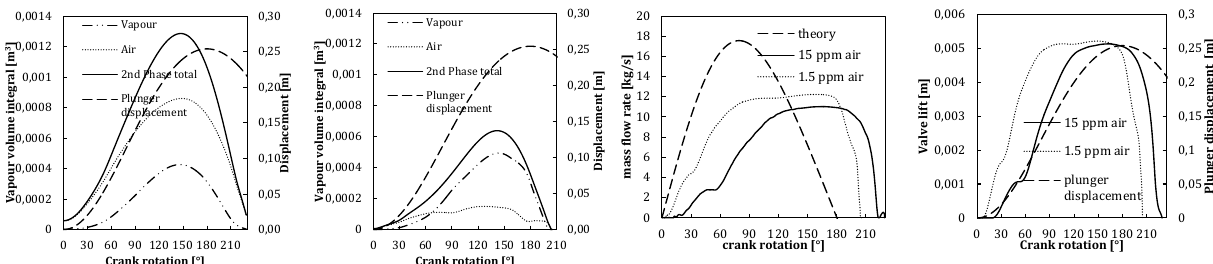
Figure 10. (left) mass flow rate throughout the inlet stroke when the air mass fraction is 15 and 1.5 ppm. (right) valve lift history.